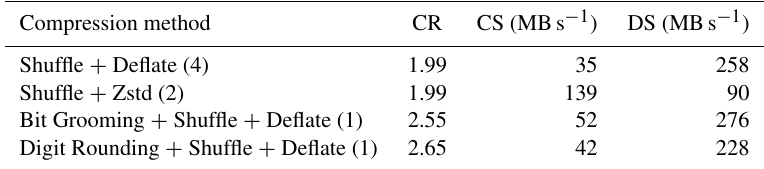
Table 13. Compression results for the representative SWOT L2 pixel cloud